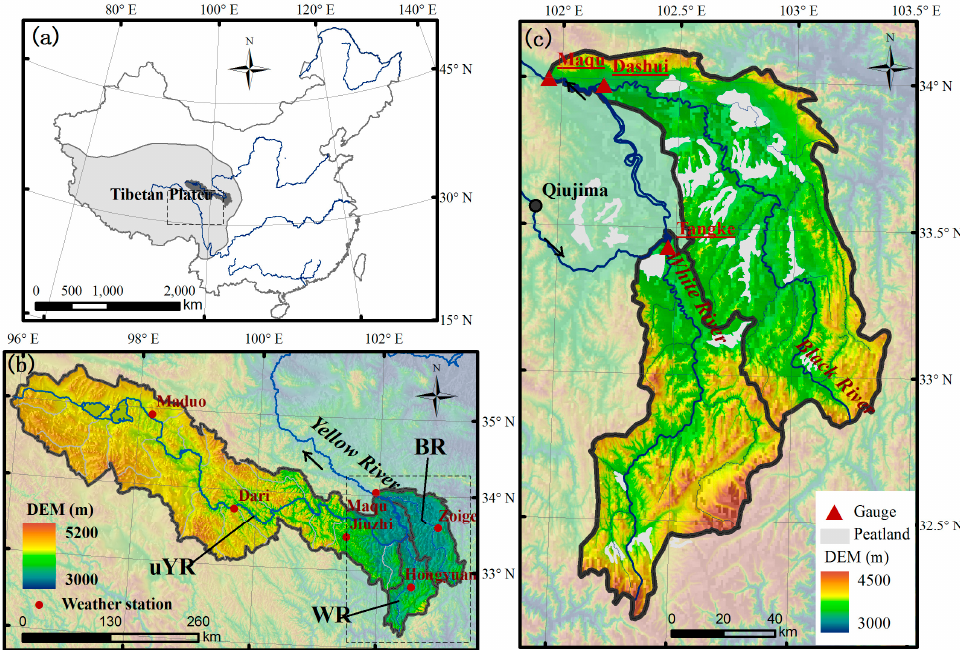
Figure 1. The location and terrain of the upper Yellow River ( a , b ) and Zoige Wetland complex ( c ). The six weather stations (Maduo, Dari, Jiuzhi, Hongyuan, Zoige and Maqu) and three hydrological gauges (Maqu on the uYR, Tangke on the WR, and Dashui on the BR) used in the study are shown in Figure 1b,c, respectively. Table 1. General characteristics of the three Tibetan Plateau basins in this study, including the upper Yellow River (uYR), White River (WR) and Black River (BR) basins. Annual mean air temperature and annual total precipitation are abbreviated as AMT and ATP, respectively.